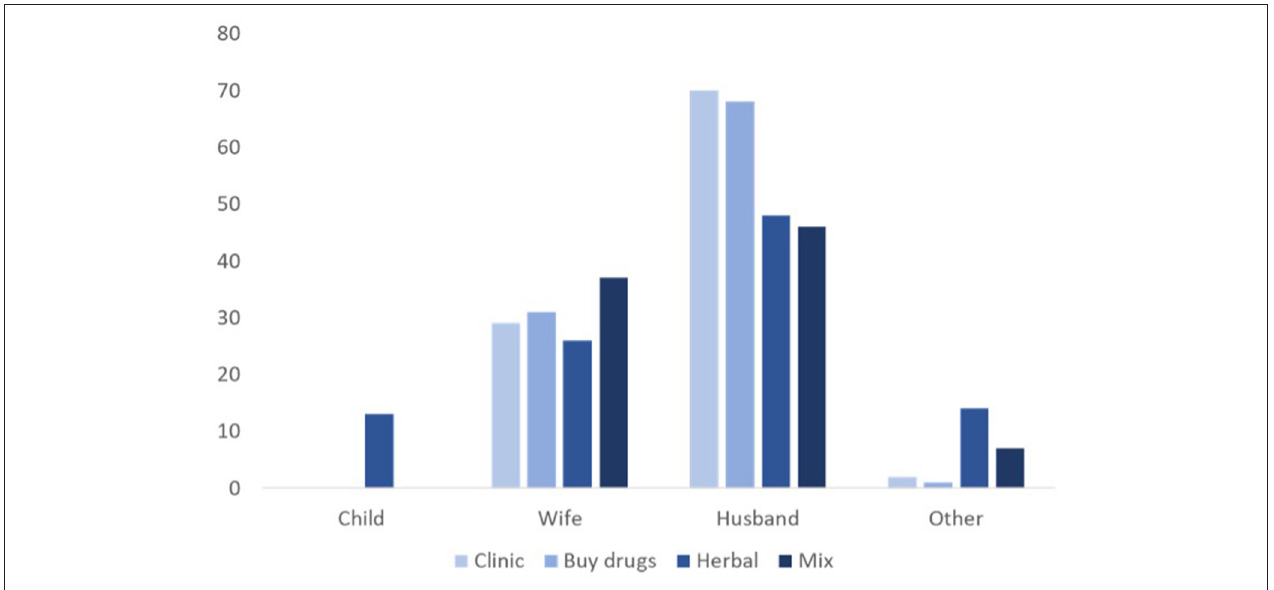
FIGURE 5 | The main decision-maker for household treatment routes in